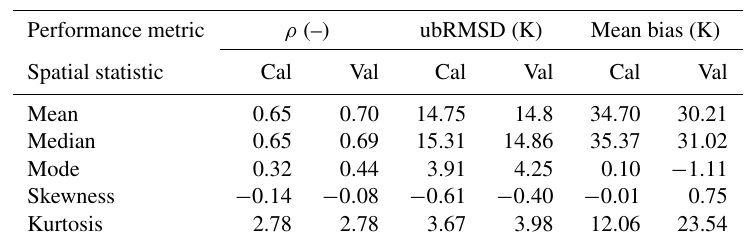
Table 3. Spatial statistics of simulated Tb performance metrics (computed using SMOS Tb as a reference). Note: Cal – calibration period; Val – validation period.